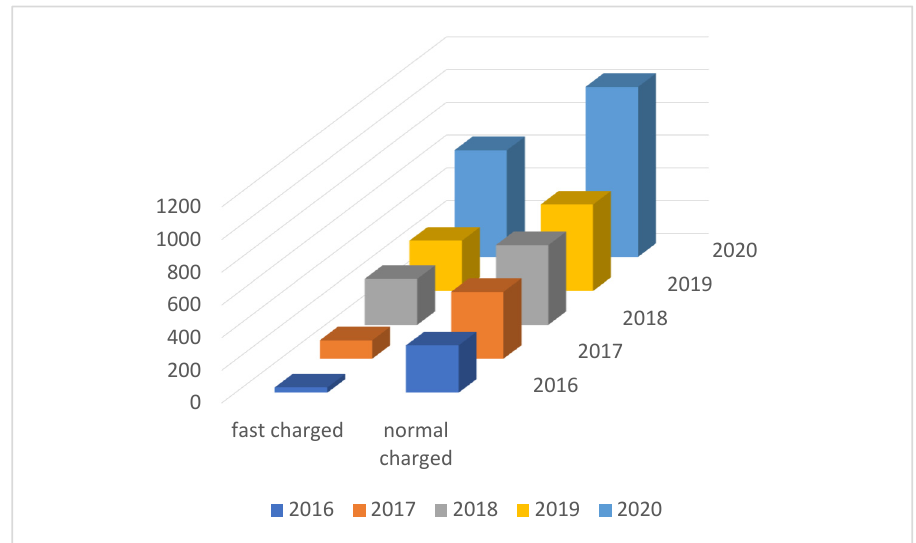
Figure 4. The total number of normal and high-power public recharging points [18]. At the same time, Poland is not a country with a large number of charging points (Figure 5).